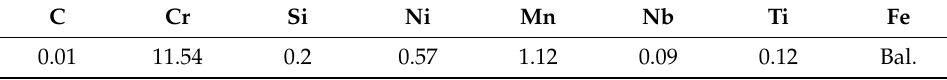
Table 1. Chemical compositions of the employed low-carbon ferritic stainless steel (wt. %).